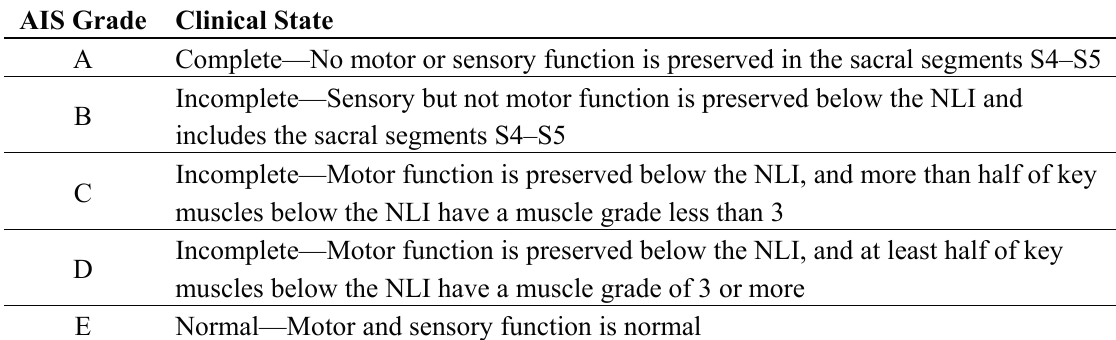
Table 3. ASIA Impairment Scale (AIS) Grade and the functional impairment (Clinical State) due to Spinal Cord Injury (SCI)